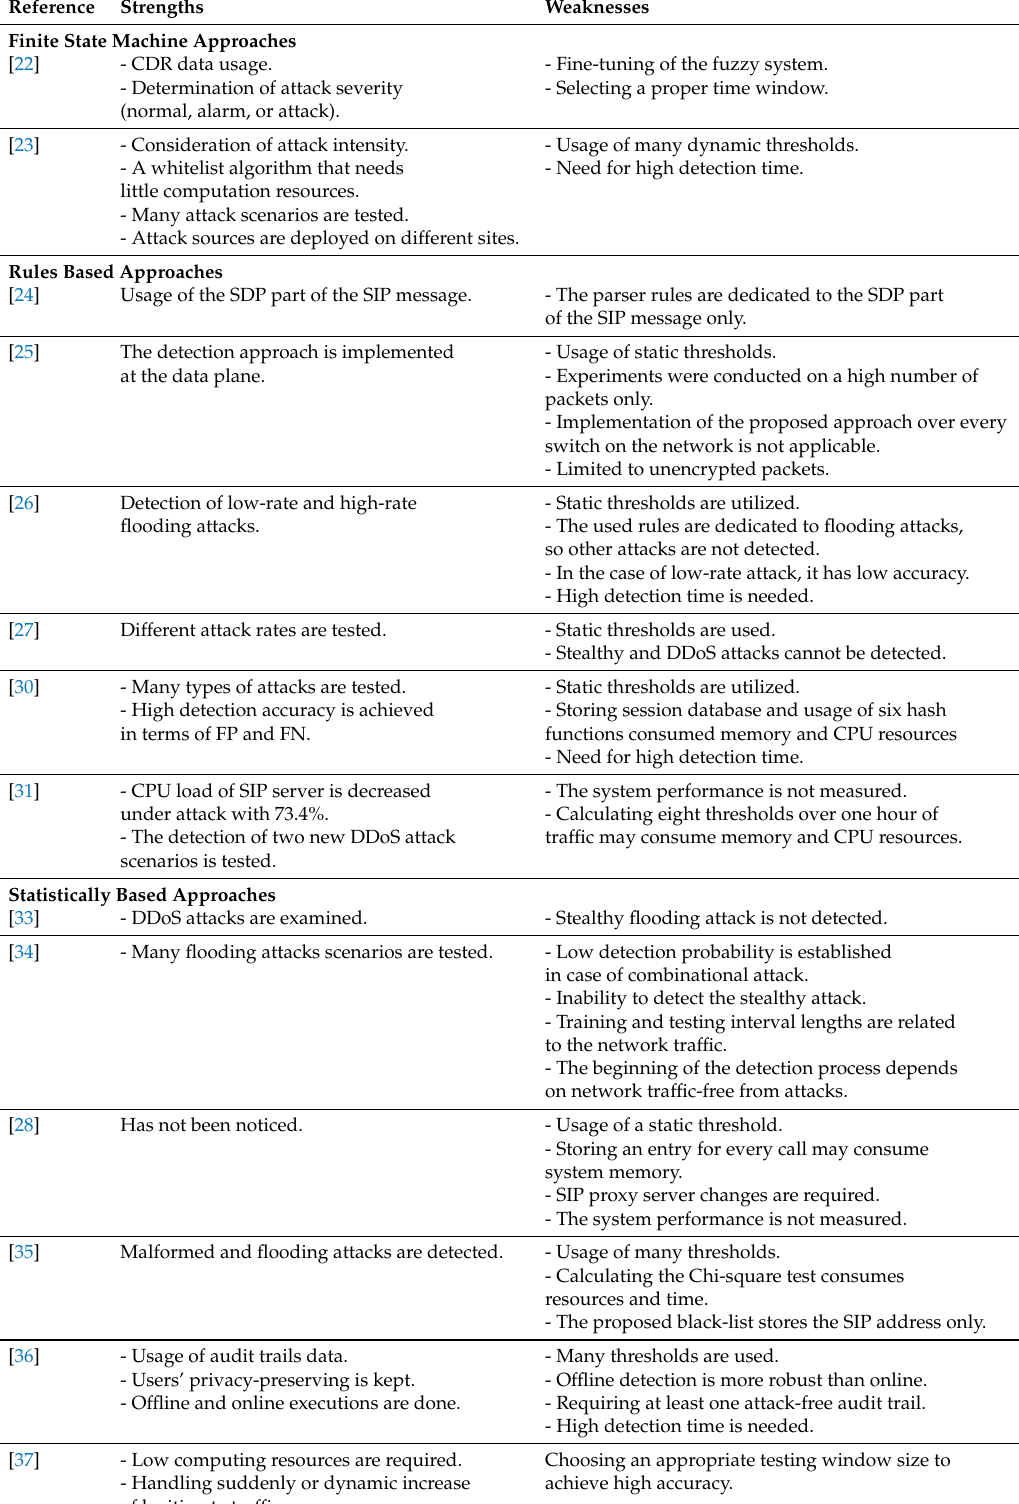
Table 3. Strengths and weaknesses of surveyed